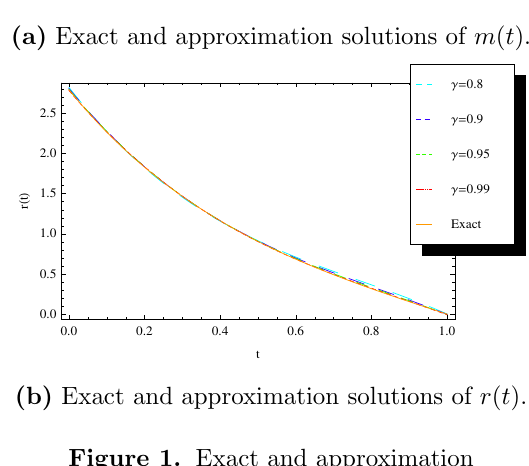
Figure 1. Exact and approximation solutions of m ( t ) and r ( t ) for N = 5 in Example 1.